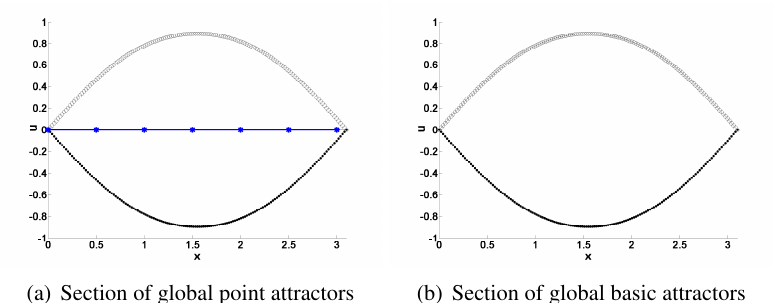
Fig. 5 Section of global point/basic attractors for S ( τ , τ − t , ω ) with case II